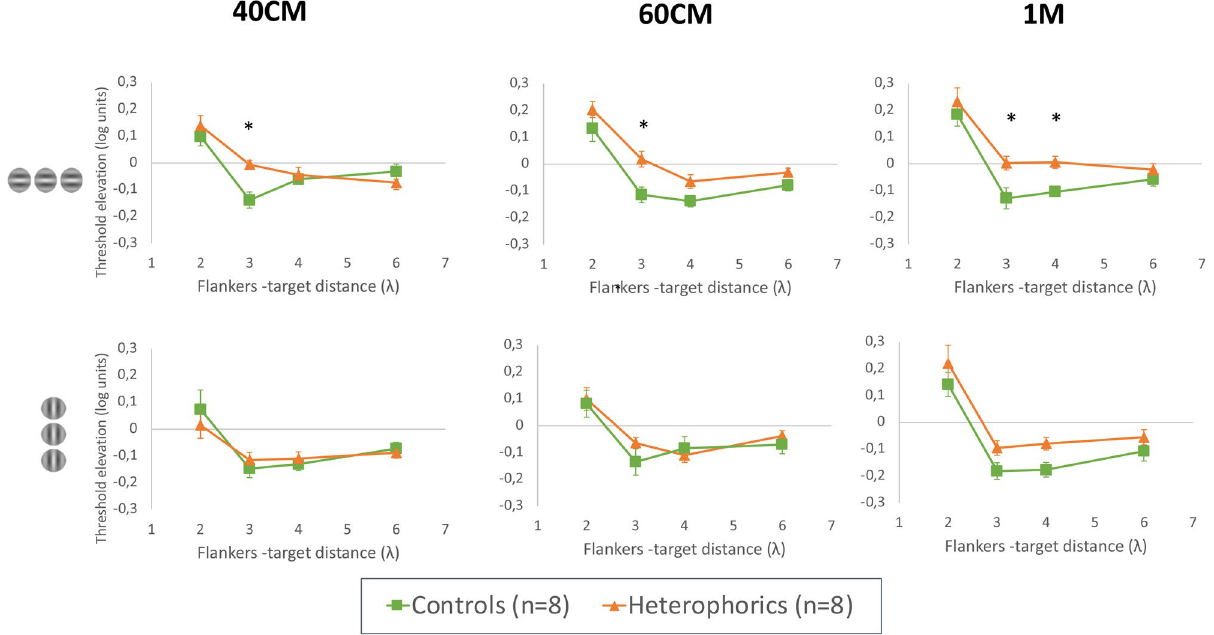
Figure 2. Average threshold elevation for the control group (n = 8) versus the heterophoric group (n = 8) as a function of the flankers to target separation. The control group is denoted by the green line and filled squares; the heterophoric group is denoted by the orange line and the filled triangle. The results for a viewing distance of 40 cm are represented on the left, for 60 cm on the middle, and for one meter on the right. Facilitation is indicated by values below zero, and suppression by values above zero. The upper line of the graphs represents the results for HM and the lower line represents the results for VM. The error bars represent the standard error of the mean (n = 8). *** p ≤ 0.001, ** p ≤ 0.01, * p ≤